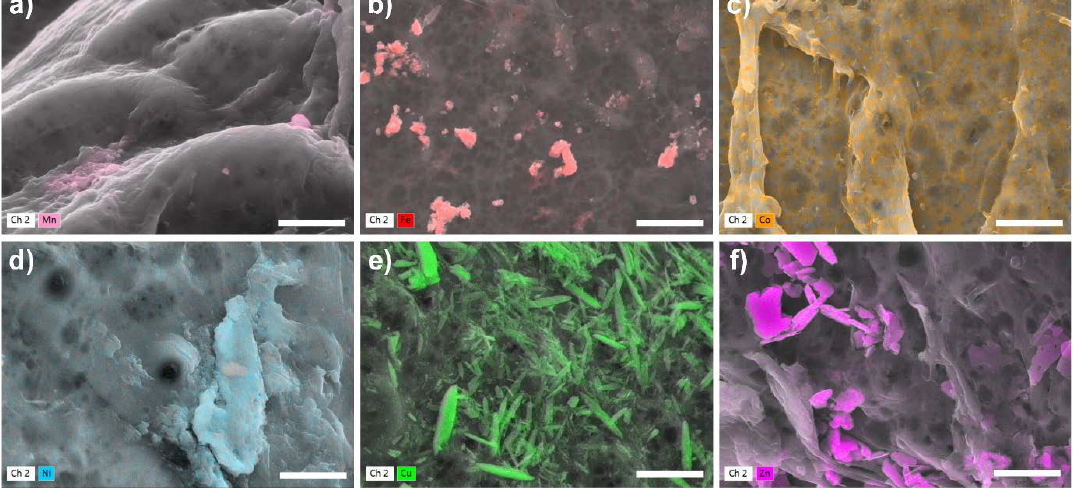
Figure 4. SEM-EDX images of: a ) Ch-MnSO 4 c 0 = 5800 mg·L −1 , b ) Ch-FeSO 4 c 0 = 5900 mg·L −1 c ) Ch-CoSO 4 c 0 = 4800 mg·L −1 , d ) Ch-NiSO 4 c 0 = 5600 mg·L −1 , e ) Ch-CuSO 4 c 0 = 4700 mg·L −1 , and f ) Ch-ZnSO 4 c 0 = 5200 mg·L −1 after the adsorption process, scale bar: 3 µm. The SEM-EDX images from all heavy